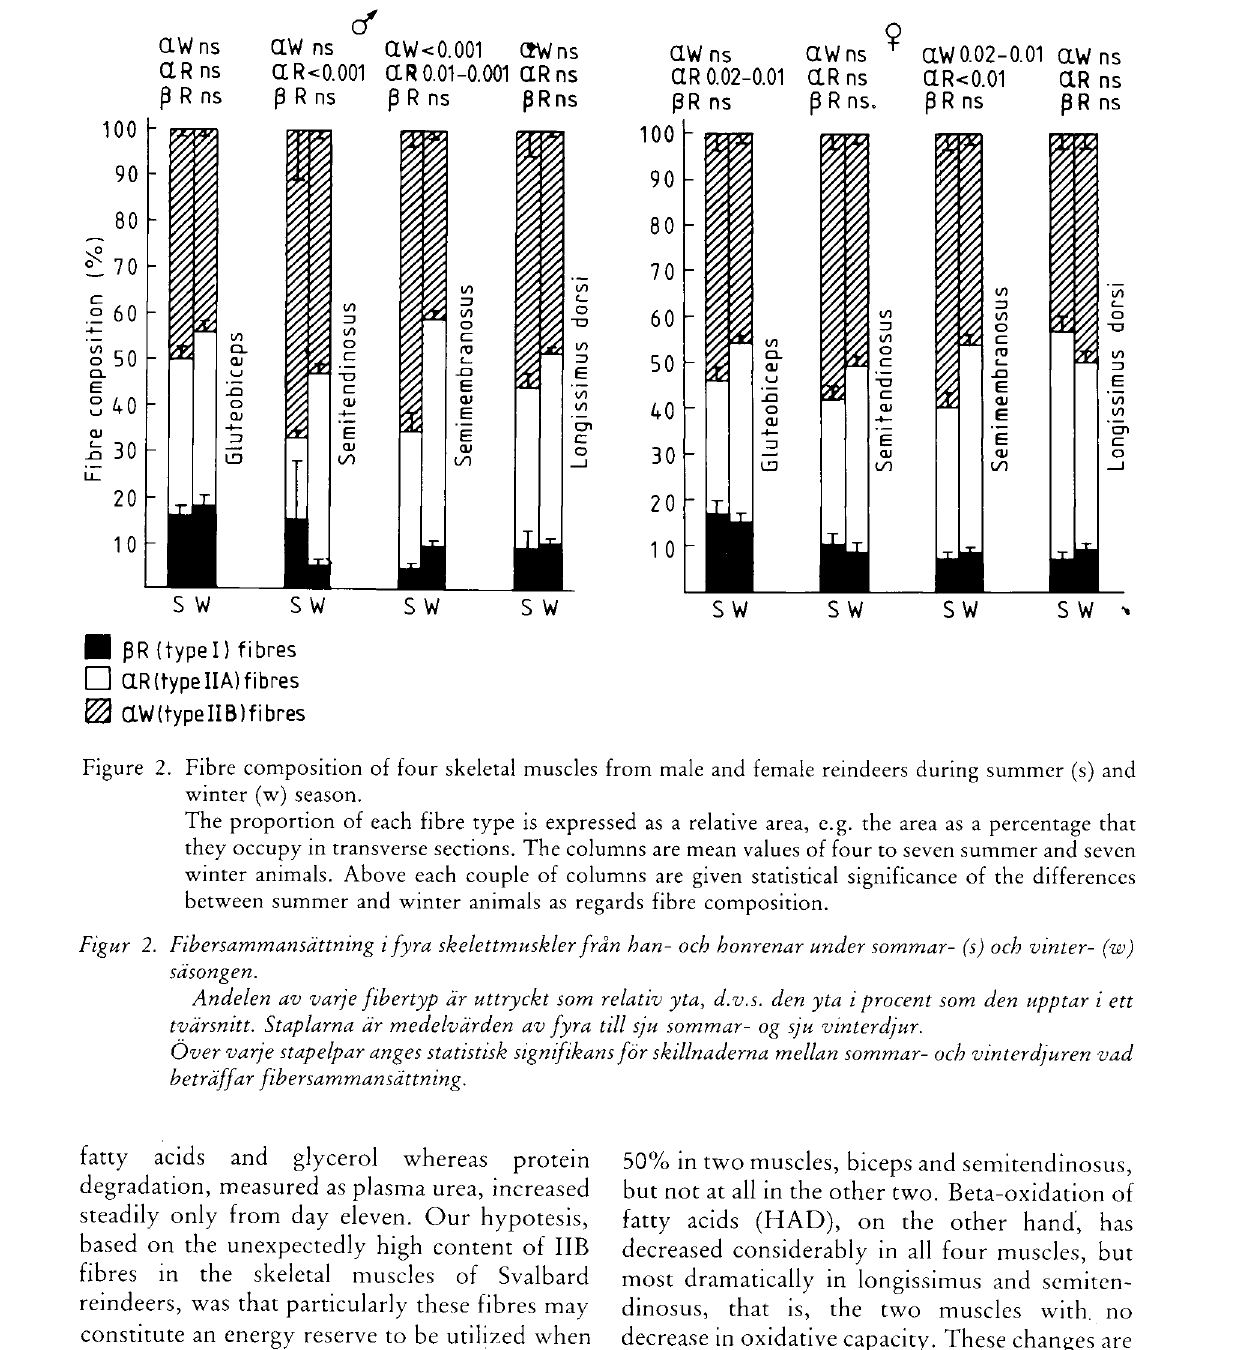
Figur 2. Fibersammansdttning i fyra skelettmuskler f rån han- och honrenar under sommar- (s) och vinter- (w)